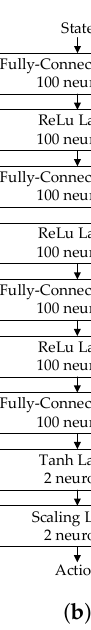
Figure 7. Diagram of the neural networks used: to approximate the action-value function by the critic ( a ); and to select the action that maximises the discounted reward by the actor ( b ) of the DDPG algorithm.